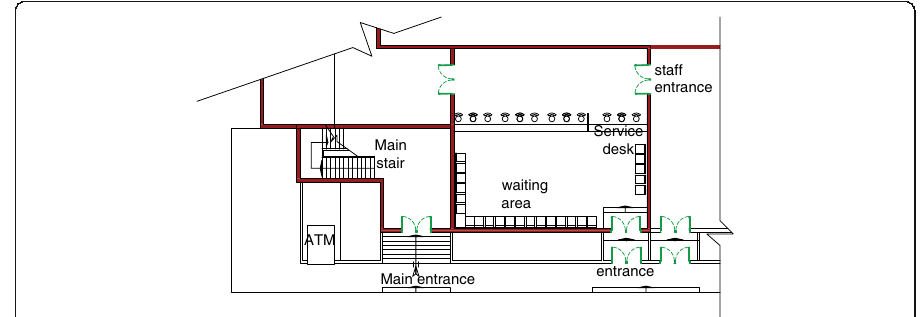
Fig. 3 Sketch floor plan for entrances and the stairs in building A. Drawn by the researcher